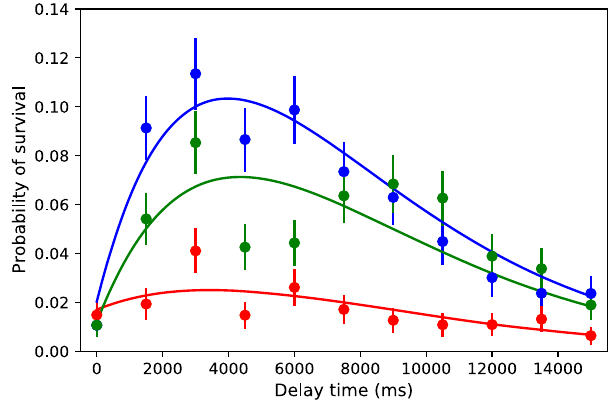
FIG. 12. By first preparing the atoms in j 0 i , waiting a variable delay, and then blowing away that spin state, the depolarization time constant T 1 can be measured. The survival probability is plotted as a function of delay time for three different magnetic field conditions: B ≈ 0 G (blue), 0.7 G (green), and 2 G (red). The lines represent the fit applied to the data. The fits yield values for T 1 of 17.0(1.5) s for the blue points, 26.7(4.8) s for the green points, and 119(29) s for the red points. Error bars represent 1 σ uncertainty of the binomial distributions given by the measured